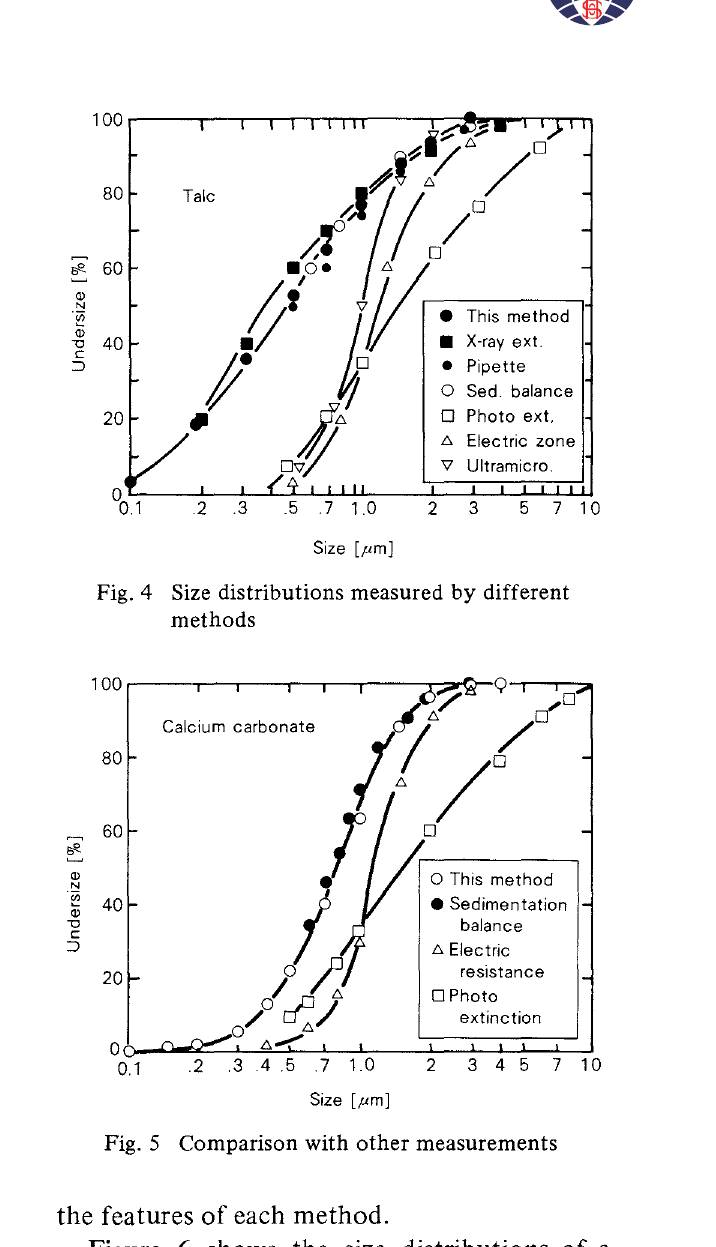
Fig. 5 Comparison with other measurements the features of each method.